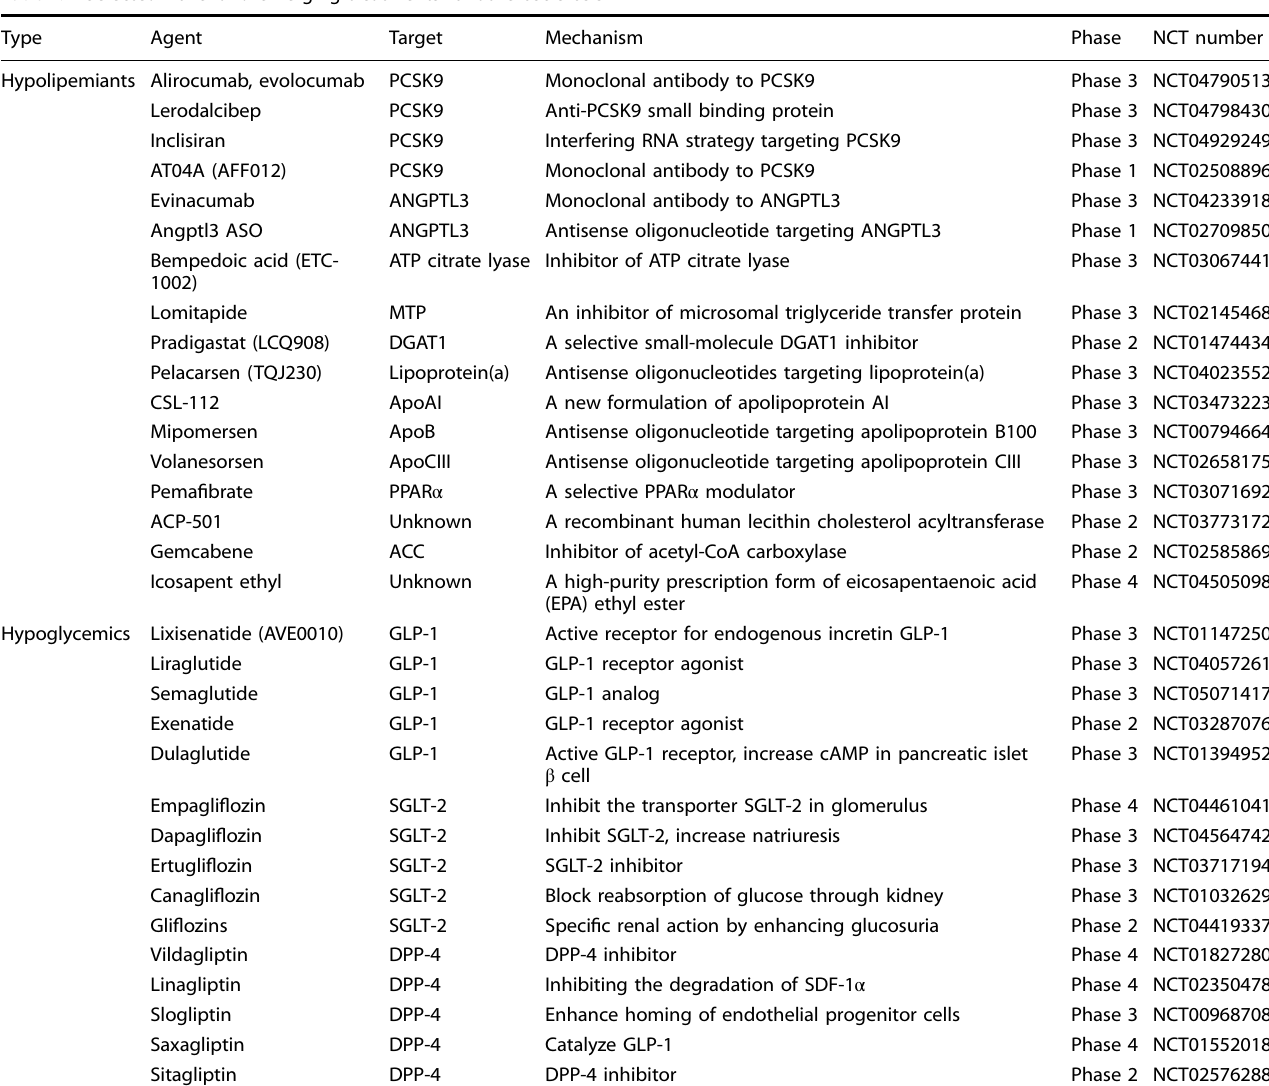
Table 1. Selected novel and emerging treatments for atherosclerosis